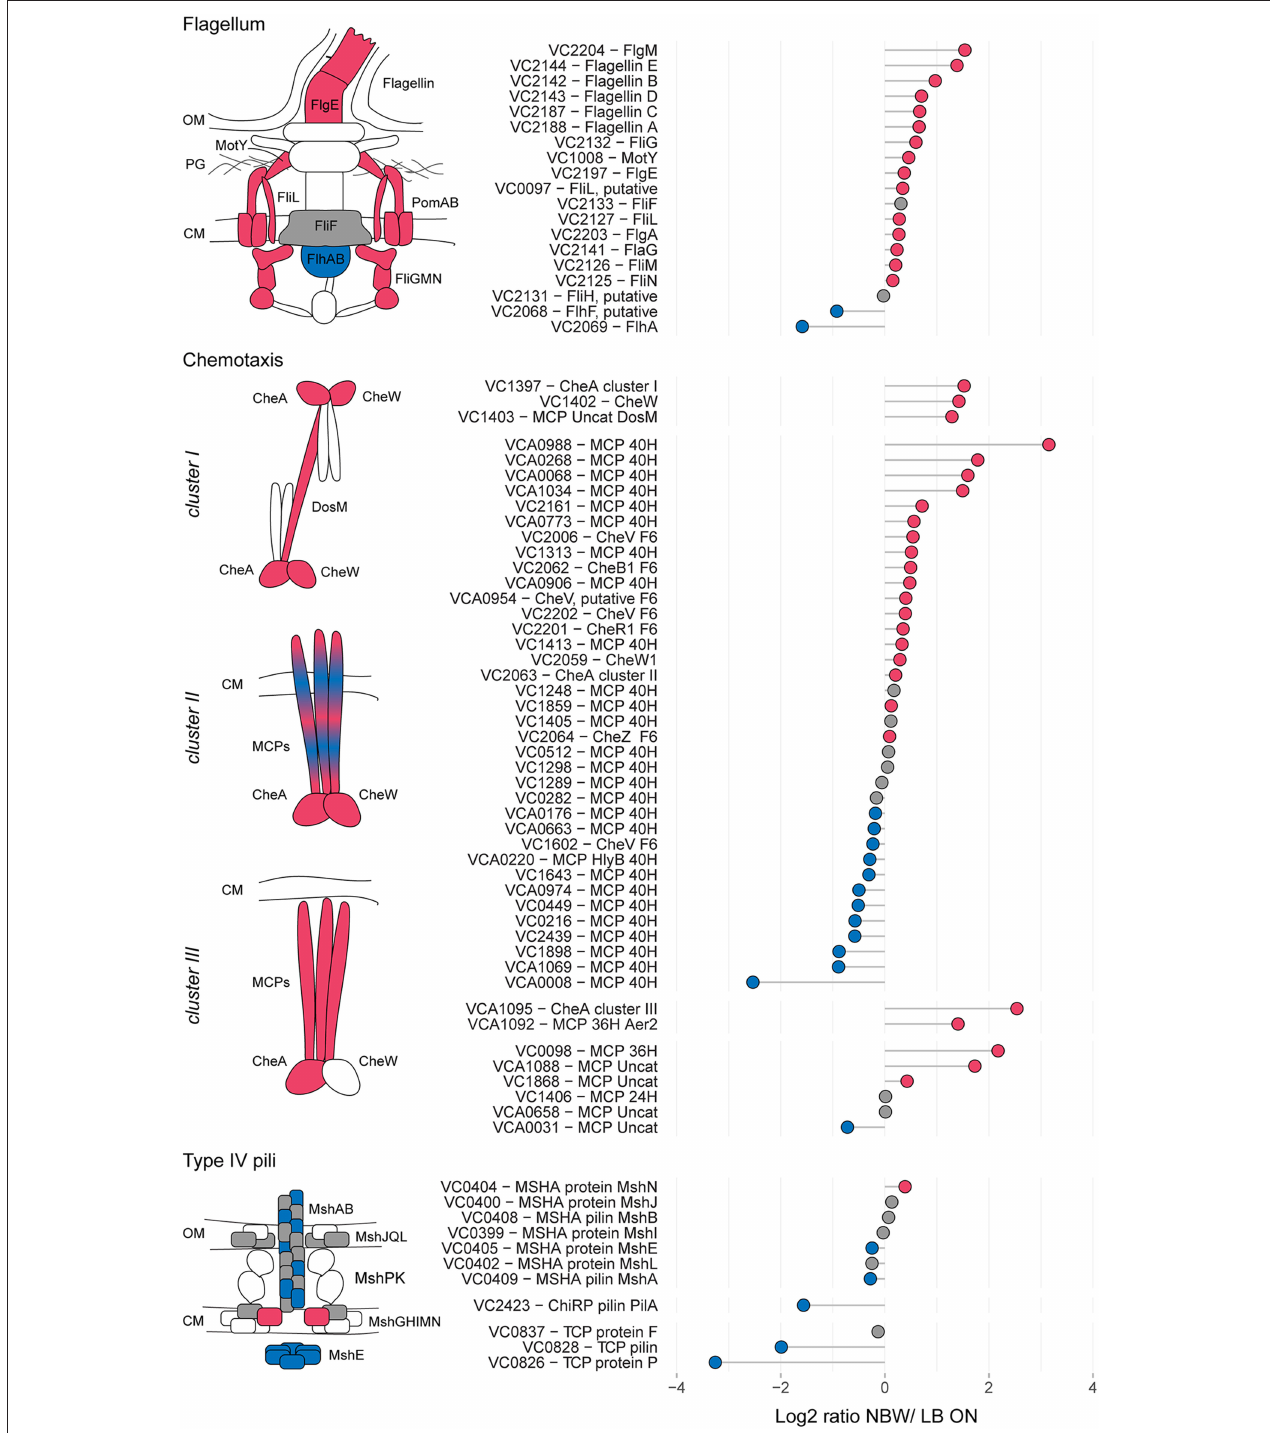
FIGURE 3 | Relative protein abundances of components of the flagellum, chemotaxis arrays and T4P. The left illustrations depict which components of the respective structures are more (red) or less (blue) abundant or not significantly different (gray). White symbols represent components that were not found in the MS analysis or with peptides n < 2. CM, cytoplasmic membrane; OM, outer membrane. Depicted is the log 2 -ratio of NBW VBNC cells and LB ON cells. Proteins found in significantly higher abundance in VBNC cells compared to LB ON are indicated by red circles while significantly lower ratios are shown as blue circles. Gray circles represent components with no significant difference between VBNC and LB ON cells (q < 0.01). Chemotaxis components are grouped by their predicted interaction with the respective chemosensory cluster.